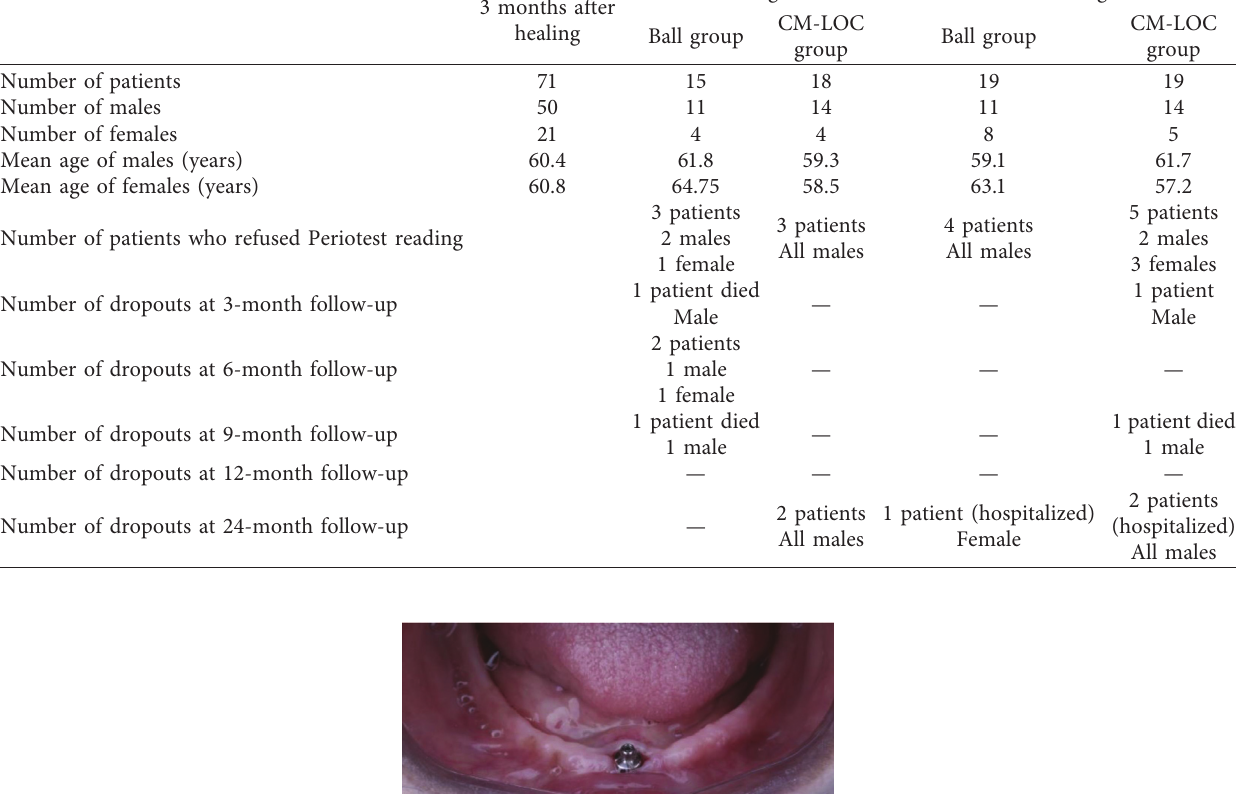
Table 1: The distribution of patients throughout the follow-up intervals for all groups of patients. 3 months after